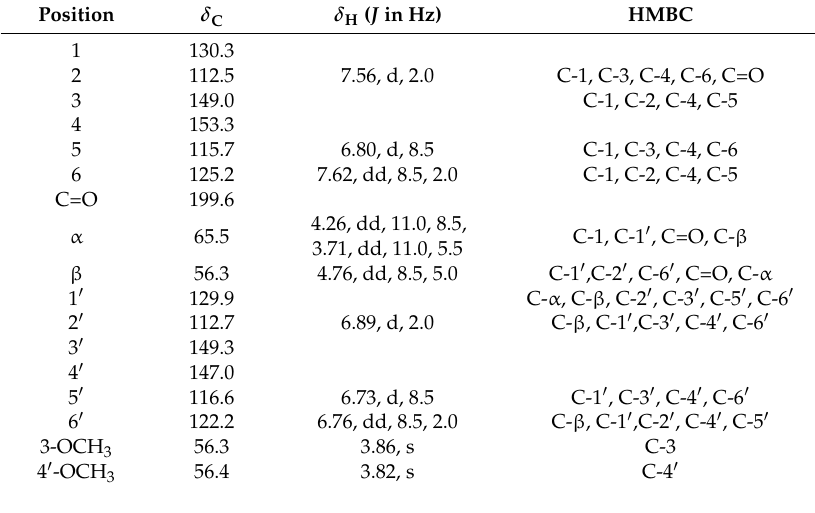
Table 1. 1 H-NMR and 13 C-NMR data of 1 (600/150 MHz, Methanol- d 4 ).